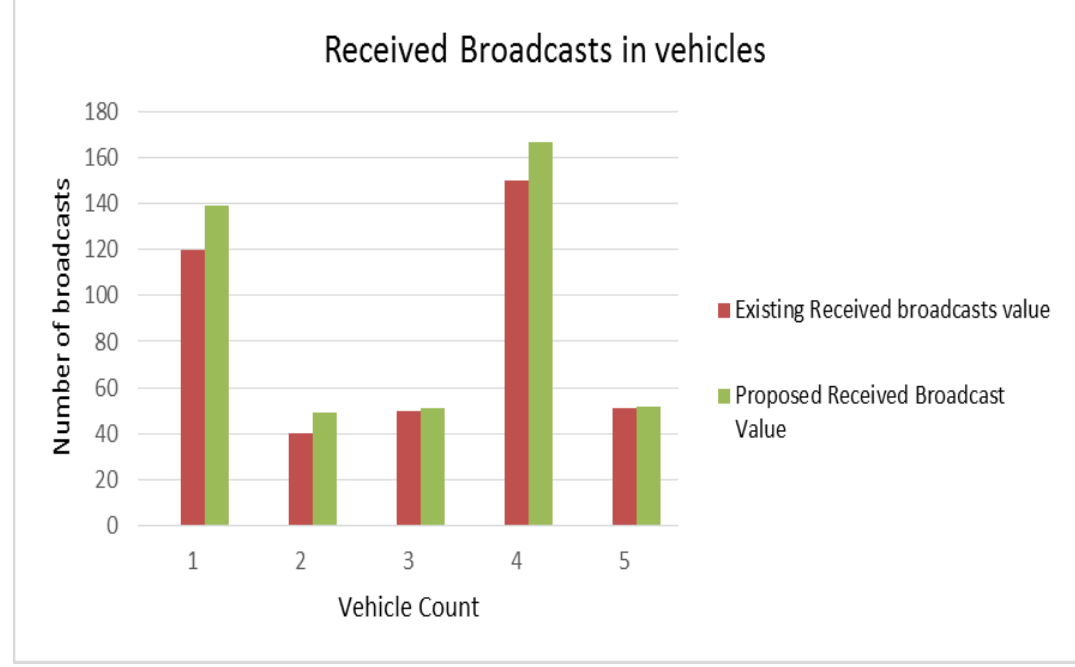
Figure 14. Received Broadcasts in vehicles